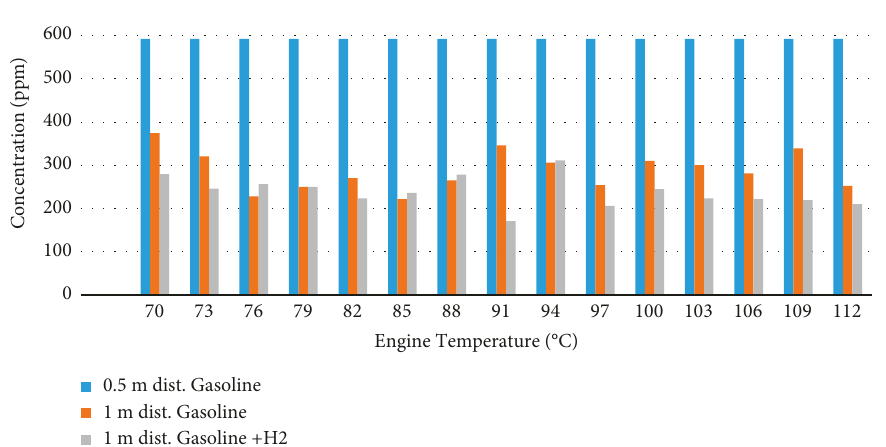
Figure 2: CO exposure at 0.5m and 1 m distances at 3000rpm engine